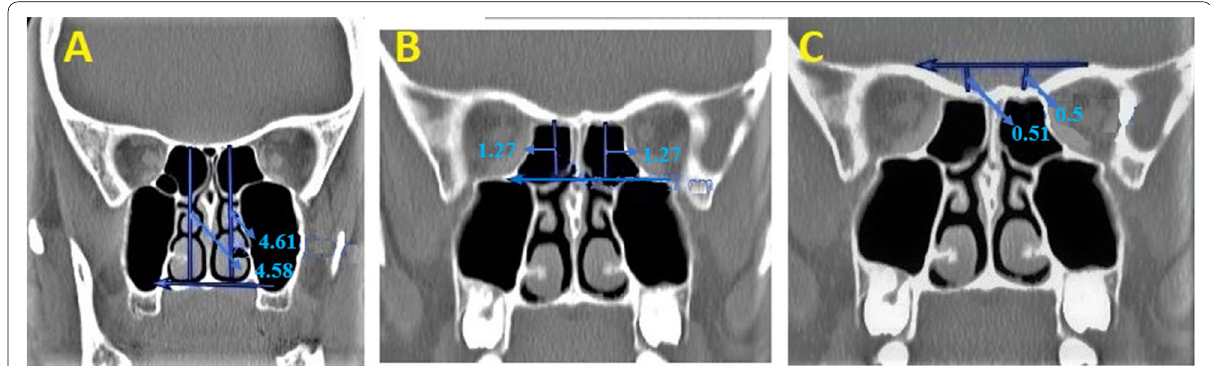
Fig. 1 CT coronal view shows th measurement of the height of the roof of the posterior sinus. A Height from the floor of the nose. B height from the roof of the maxillary sinus. C Distance from the orbial